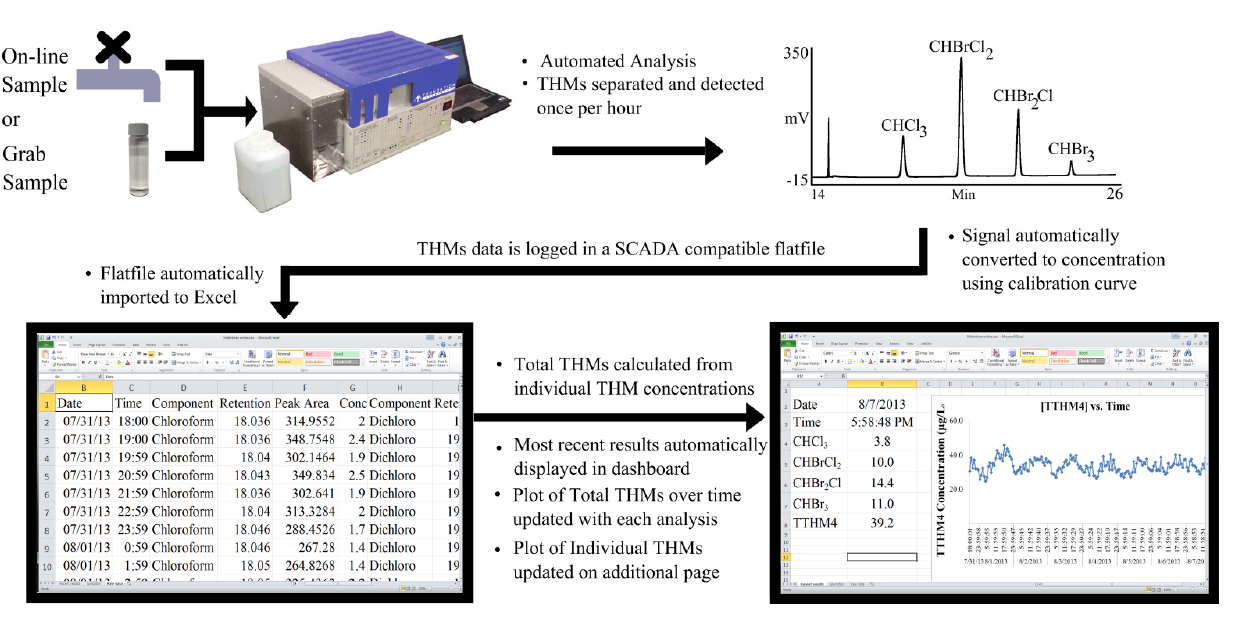
Figure 1. Illustration of operation of the Trihalomethanes-Rapid Response (THM-RR) system used to establish the program for automated on-line monitoring of individual and Total THMs concentrations in Lebanon, TN water treatment plant